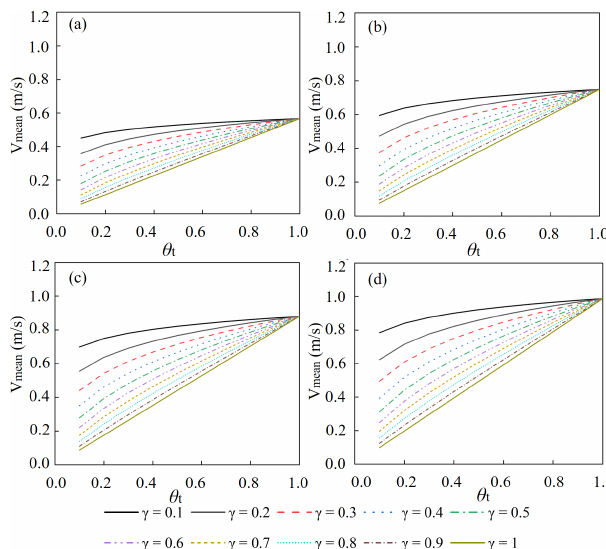
Figure 17. The theoretical curve of mean velocity and soil mois- ture content for the Longhu River basin. (a) I t = 1 . 5. (d) I t = (c) I t I c I c